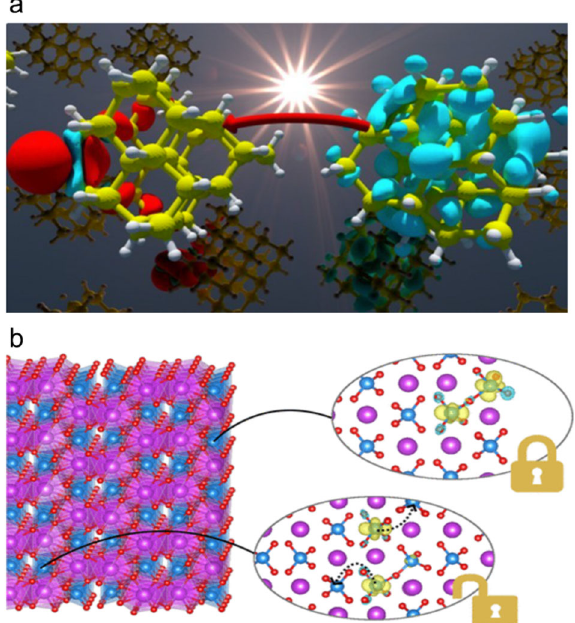
Fig. 5 Transport from fi rst principles. Charge transfer excitation processes in assemblies of hydrogenated Si nanoparticles 148 (panel a ) and in the bulk and at the surface of crystalline BiVO 4149,150 (panel b ), investigated using constrained density functional theory 18 . Panel b is reproduced with permission from ref. 150 , copyright (American Chemical Society,